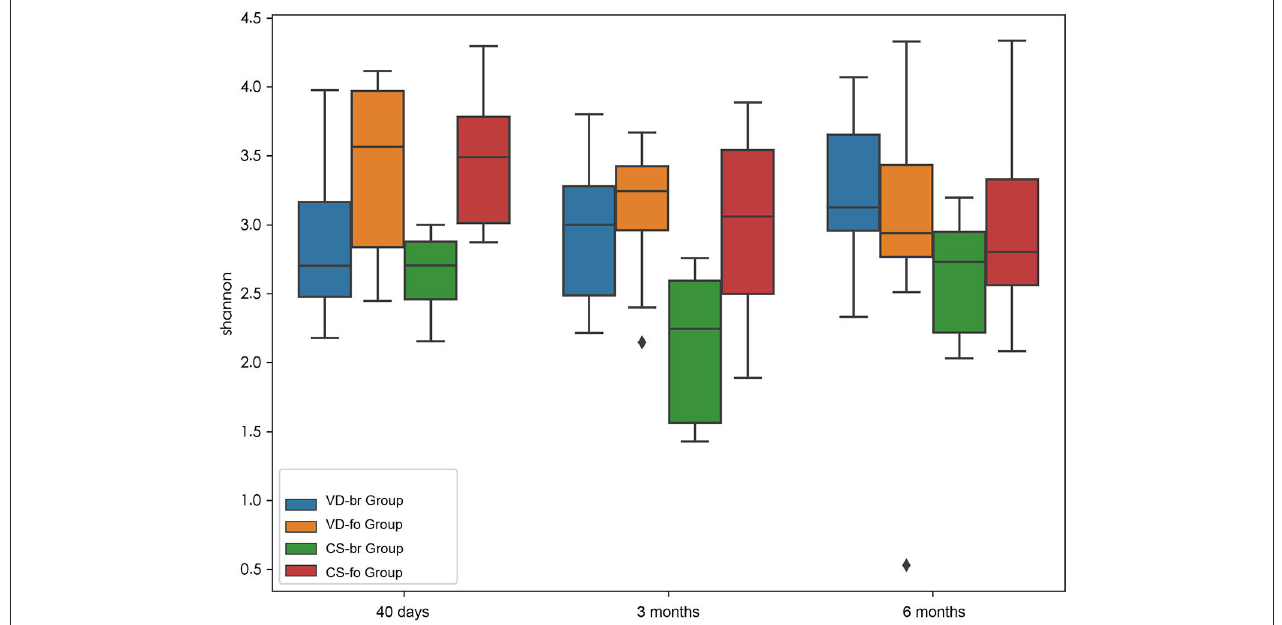
FIGURE 1 | α diversity measurements using Shannon index values indicated gut microbiota diversity. Y-axis represents the values of Shannon index. Boxplots compare α diversity of gut microbiota in 40 days (40 d), 3 months (3m), and 6 months (6m) of age among different groups. Boxes show 25th to 75th percentiles and the median line, and whiskers indicate minimum to maximum values. Statistical significance was evaluated by Wilcoxon test within each group and a two-tailed t test among different groups, using p ≤ 0.05 as the measure of